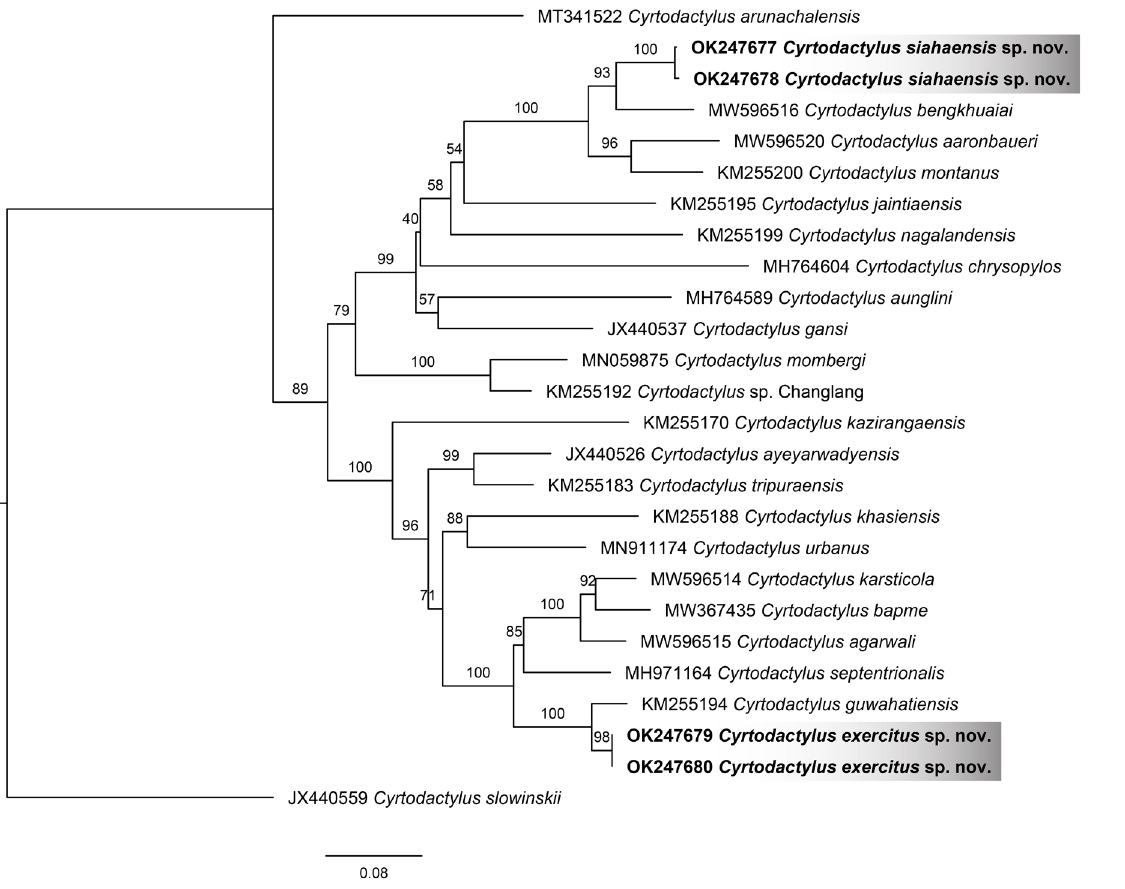
Fig. 2. Maximum Likelihood phylogeny of the Cyrtodactylus khasiensis group; numbers at nodes represent bootstrap support (preceding the species name is the NCBI accession